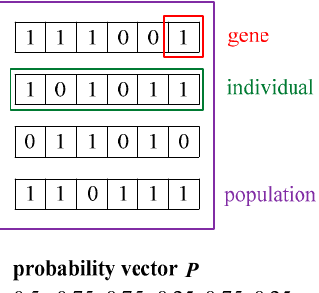
Figure 2. Genetic representation of the solution domain.